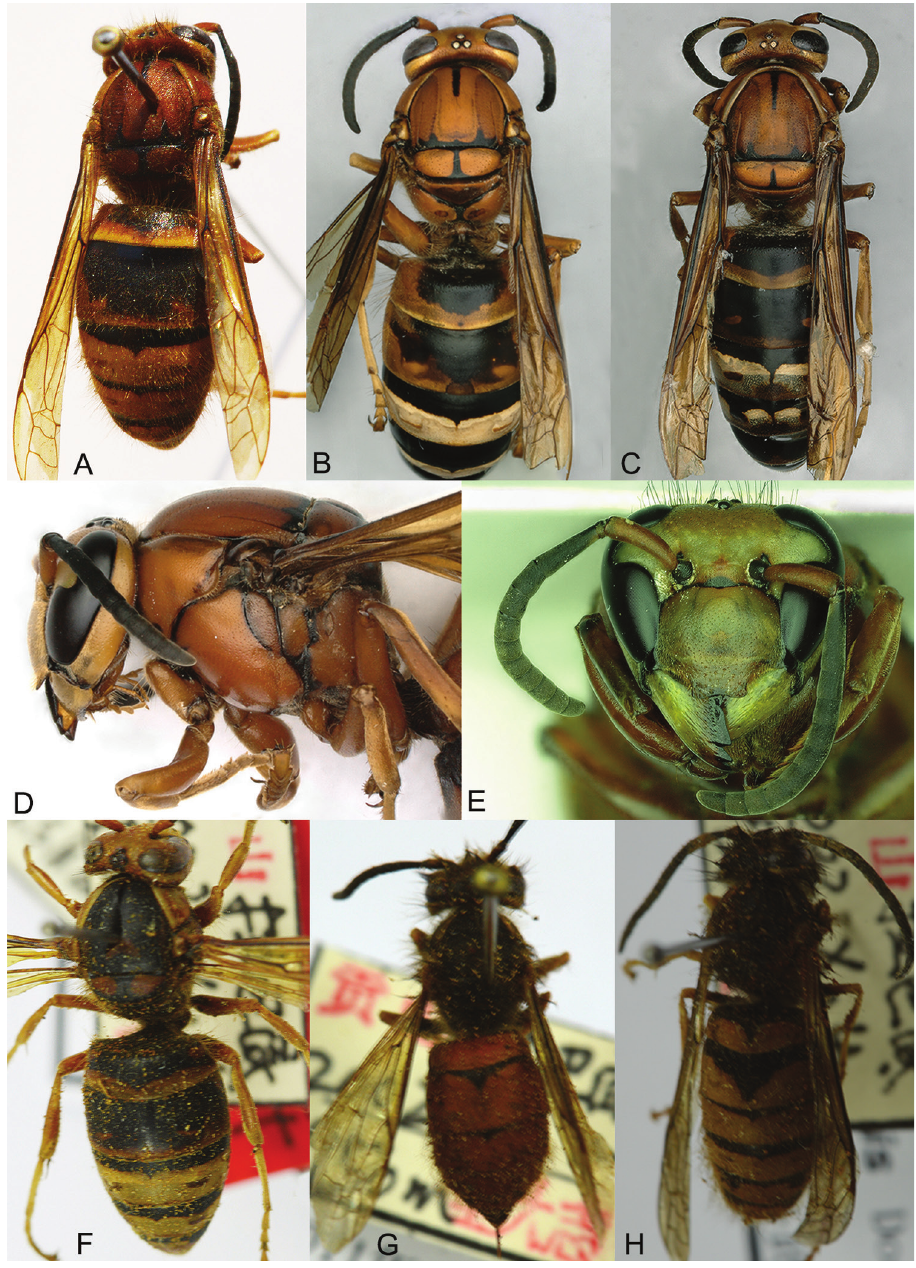
Figure 3. Vespula structor (Smith). A–E Queen ( ♀ q): A Habitus (from Ningxia), dorsal view B habitus (from Baoji, Shaanxi), dorsal view C habitus (from Xunyangba, Shaanxi) D head and mesosoma, lateral view E head, anterior view. F–H Vespula gongshanensis (type series from Yunnan) F Queen ( ♀ q), habitus, dorsal view G worker ( ♀ w), habitus, dorsal view H male ( ♂ ), habitus, dorsal